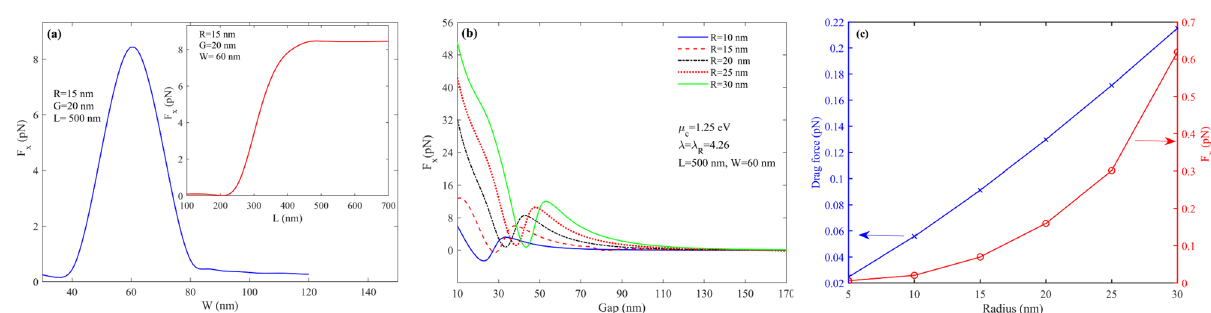
Figure 8. F x for ( a ) an R = 15 nm particle L = 500 and w between 30 and 120 and w = 60 nm and L between 100 and 700 ( b ) R = 10 to 30 nm and G between 10 and 170 nm ( c ) drag and F x for particles with R = 5,10,15,20,25 and 30 nm.